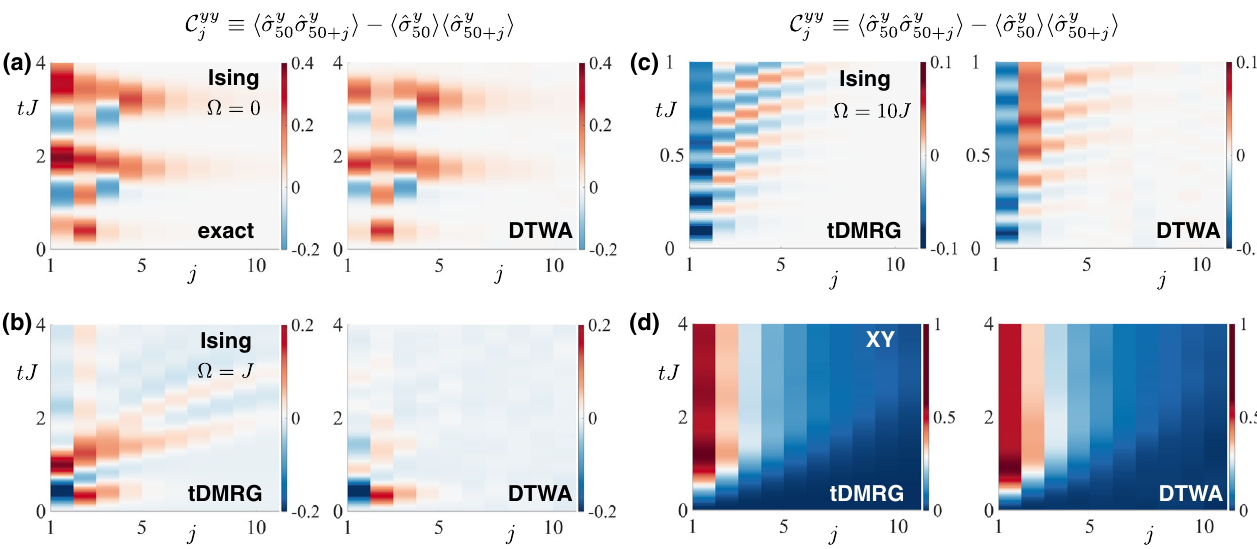
FIG. 4. Spreading of correlations. Time evolution of C yy j in a system with N ¼ 100 spins on M ¼ 100 sites for long-range interactions with decay exponent α ¼ 3 . We consider three models [Eq. (4)]: (a) Ising interactions, (b),(c) Ising interactions plus a transverse field P ˆ σ x XY interactions. We compare exact or tDMRG results (left-hand side) with results obtained from the DTWA (right- term Ω i i , and (d) hand